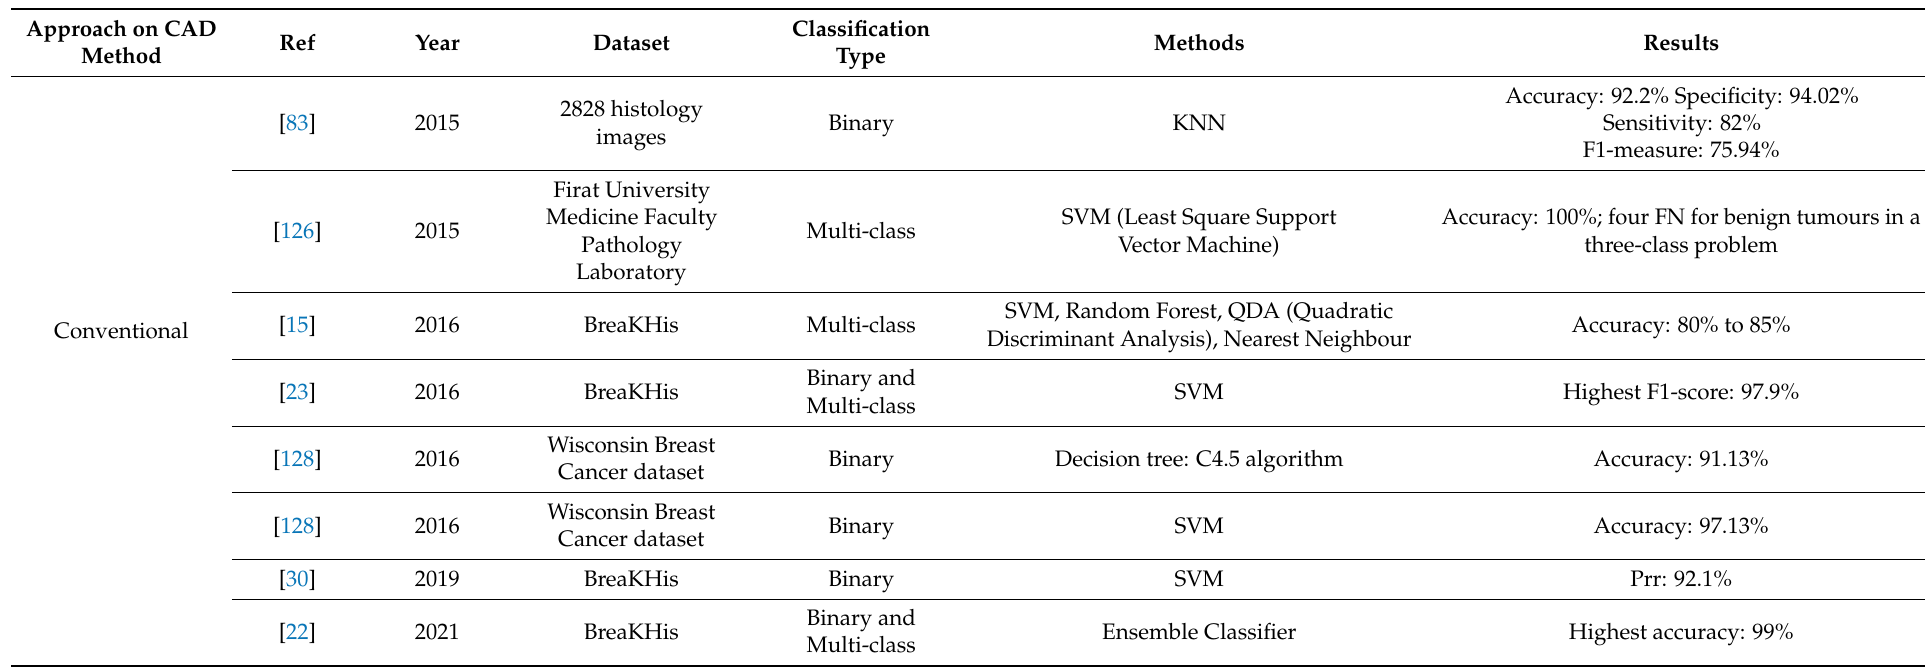
Table 6. Comparison of different methods for breast cancer diagnosis